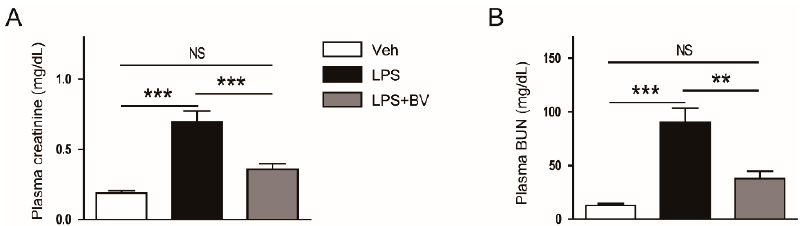
Figure 1. Bee venom alleviated renal dysfunction in mice treated with lipopolysaccharide (LPS). Mice received a single intraperitoneal injection of bee venom (100 µ g / kg body weight) 1 h before injection of LPS (10 mg / kg body weight). ( A ) Plasma creatinine. ( B ) Plasma blood urea nitrogen (BUN). ** p < 0.01 and *** p < 0.001. NS, not significant.